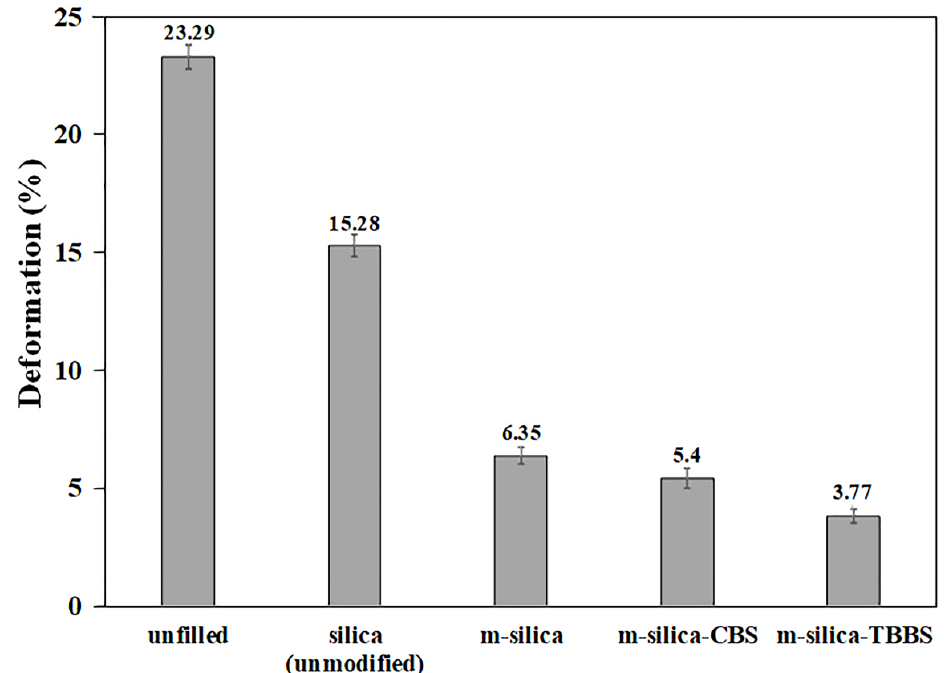
Figure 7. The deformation percentage of rubber rail pads.